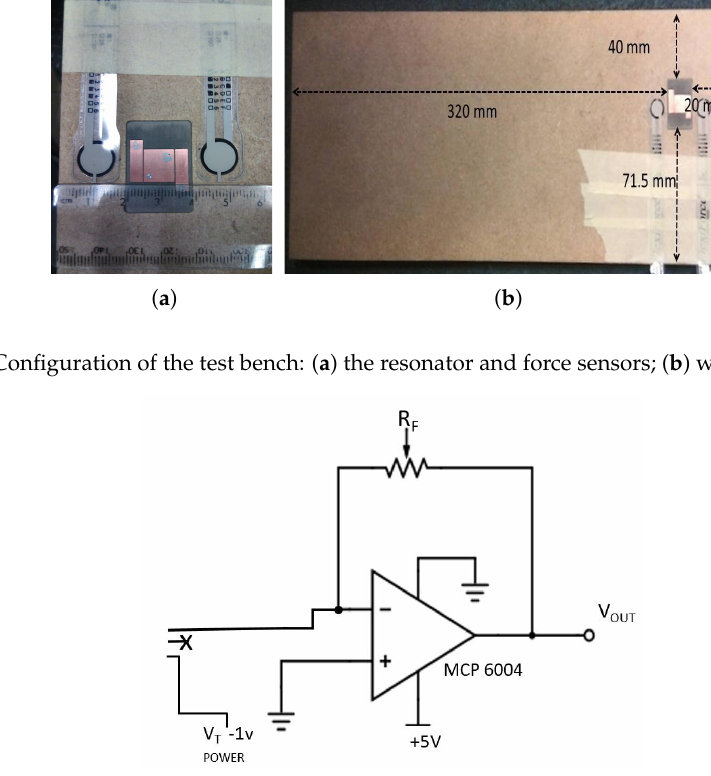
Figure 7. Conditioning circuit for thin-film force sensors [76].